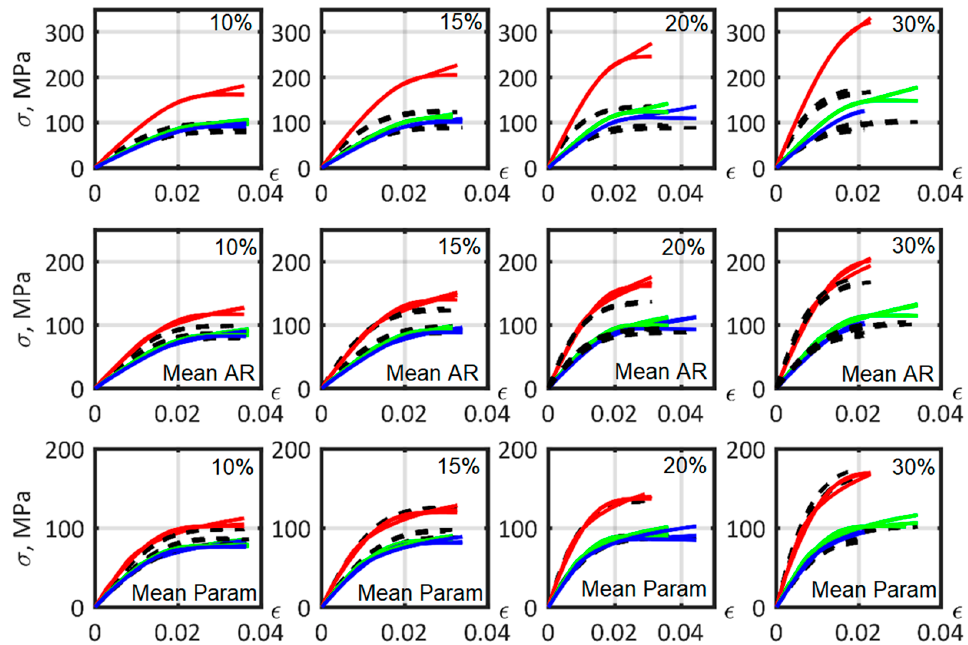
Figure 16. Stress–strain curves for the model material for PA6 with different short carbon fiber mass fractions, orientated in different directions. From left to right: 10%, 15%, 20%, and 30% fiber mass fraction. From top to bottom: non-calibrated parameters; calibrated fiber aspect ratio; all matrix parameters and fiber aspect ratio calibrated. Material model—color lines: 0°—red lines, 45°—green lines, 90°—blue lines. Experimental data—black dashed lines.